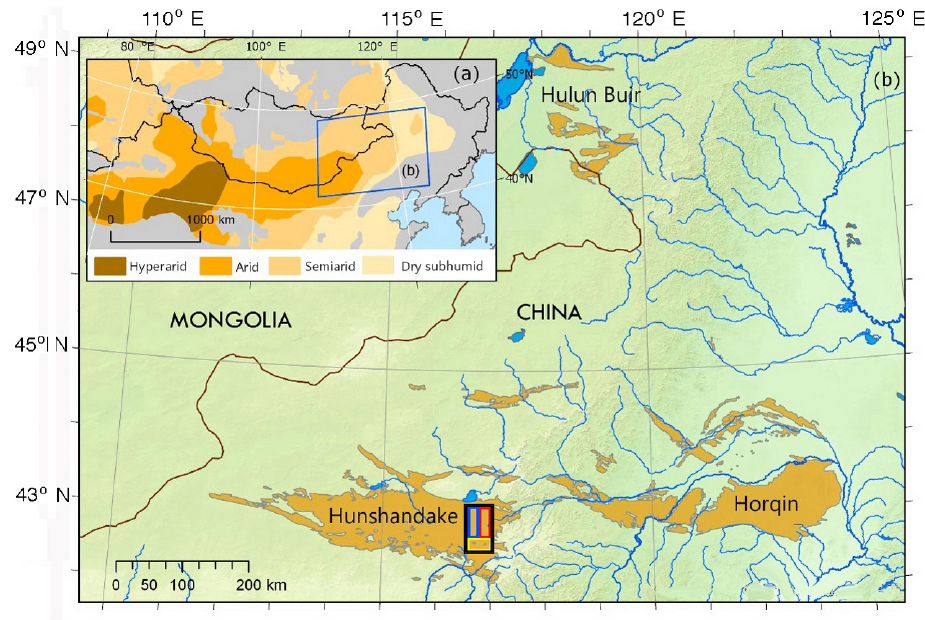
Figure 1. Sandy Lands of northeastern China. (a) Distribution of deserts across China by climate type. (b) Sandy land distribution. Boxed area in Hunshandake Sandy Lands is study area reported in this study. Regions: south – yellow; west – blue; east –